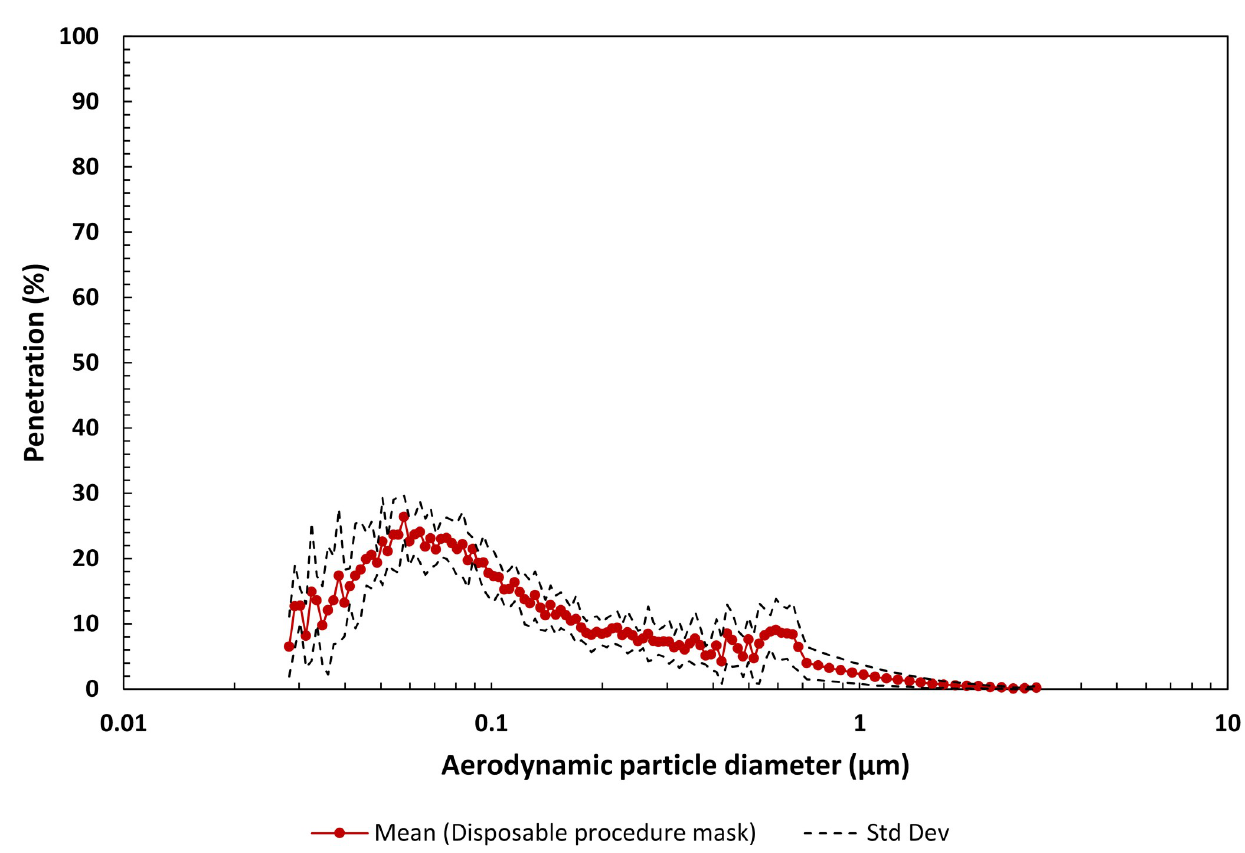
Fig 6. Mean penetration profile as a function of aerodynamic particle diameter for the filter material of six disposable procedure masks. Note, the penetration range is 0 to 100%. The bump in the penetration data between the particle range 0.5 to 0.67 μ m is related to averaging the SMPS and APS